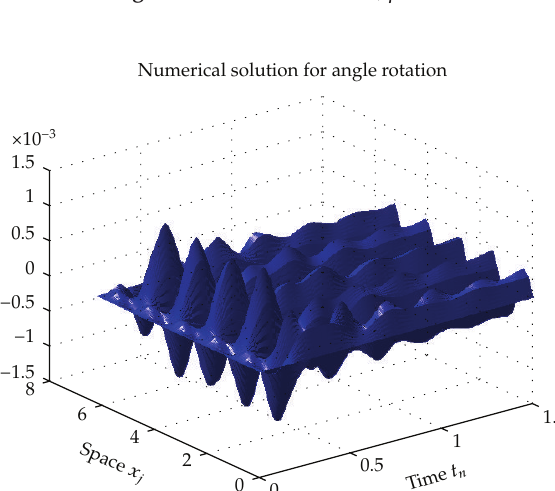
Figure 9: Conservative case, μ (cid:8) 10.